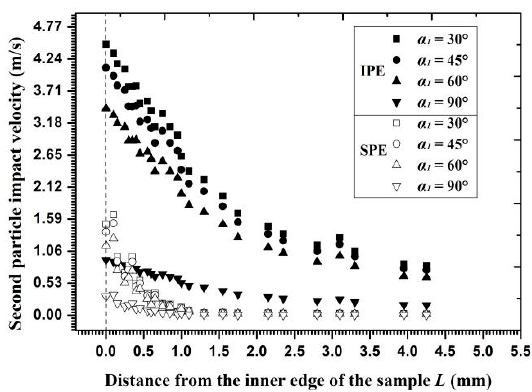
Figure 20. The second particle impact velocity on the wall for interferential particle erosion (IPE) and stacked particle erosion (SPE). The second impact particle is particle j in IPE as well as is particle i in SPE.